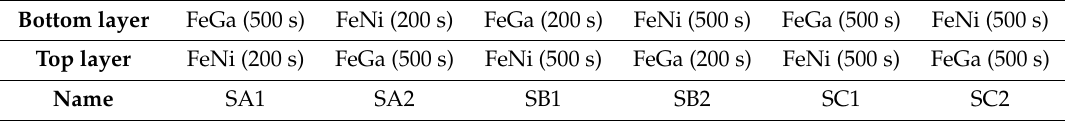
Table 1. Sample name with deposition